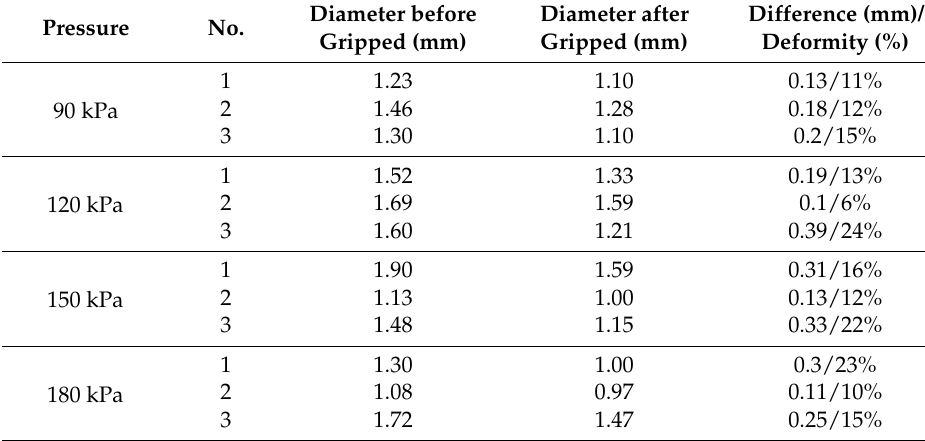
Figure 11. The deformation measurement experiments on digital nerves: ( a ) the schematic diagram for the deformation measurement experiments; ( b ) measuring the original diameter of the ink-marked area; ( c ) gripping the ink-marked area using the proposed surgical gripper; and ( d ) measuring the diameter of the ink-marked area after being gripped. Table 2. Results of the deformation experiments.